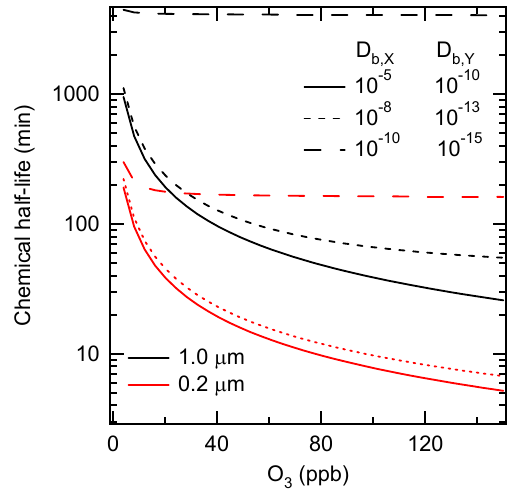
Fig. 11. Chemical half-life (min) of pure oleic acid particles with particle radius of 1.0 (black) and 0.2µm (red) as a function of gas phase O 3 mixing ratio. The diffusion coefficients are D b , X = 10 − 5 cm 2 s − 1 , D b , Y = 10 − 10 cm 2 s − 1 (solid line, BC1), D b , X = 10 − 8 cm 2 s − 1 , D b , Y = 10 − 13 cm 2 s − 1 (dotted line), and D b , X = 10 − 10 cm 2 s − 1 , D b , Y = 10 − 15 cm 2 s − 1 (dashed line, BC3).